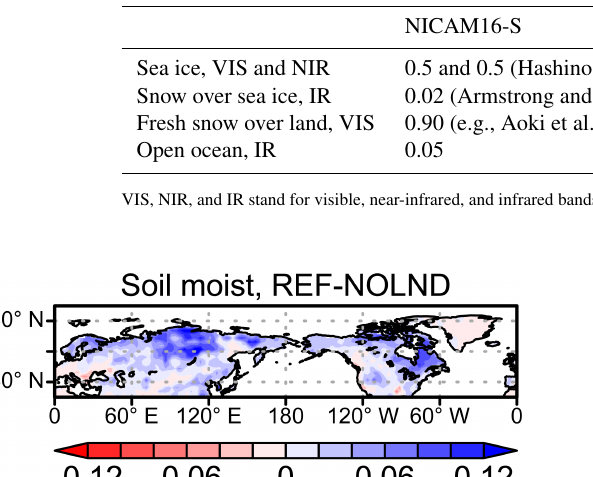
Figure 9. Impact of the aerosol treatment update (the REF run minus the NOAER run). Two-dimensional distribution, zonal, and global means of the net longwave (a, c) and shortwave (b, d) radiation at the surface are shown for the NICAM16-9S (a, b) and NICAM16-7S (c, d) runs. The data are gridded at 1 ◦ in longitude and latitude, and the sign of the radiation is downward positive. Table 6. Surface albedo in NICAM16-S and NICAM.12.